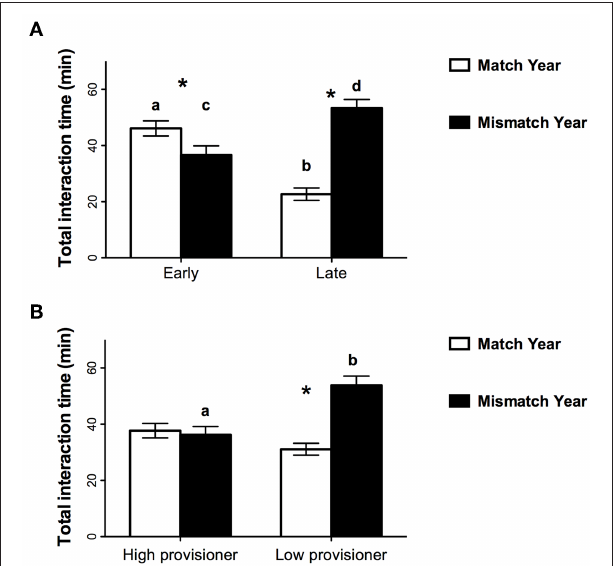
FIGURE 3 | Mean ( ± SE) time for nest interactions with fish in the match (1999) and mismatch (2000) years (A) before (early) and after (late) capelin arrived inshore and (B) for low and high provisioning brooding murres. Different letters for bars of the same color indicate significant differences between early and late in the season (A) and high and low provisioners (B) whereas * indicates a significant difference between